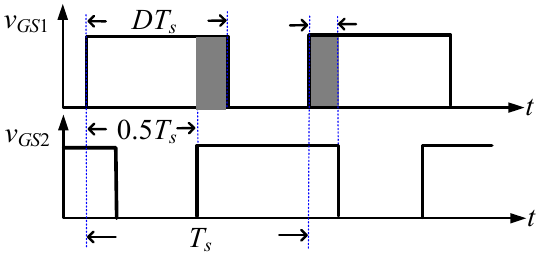
Figure 2. High-frequency waveforms of gated voltages v g S 1 and v g S 2 .